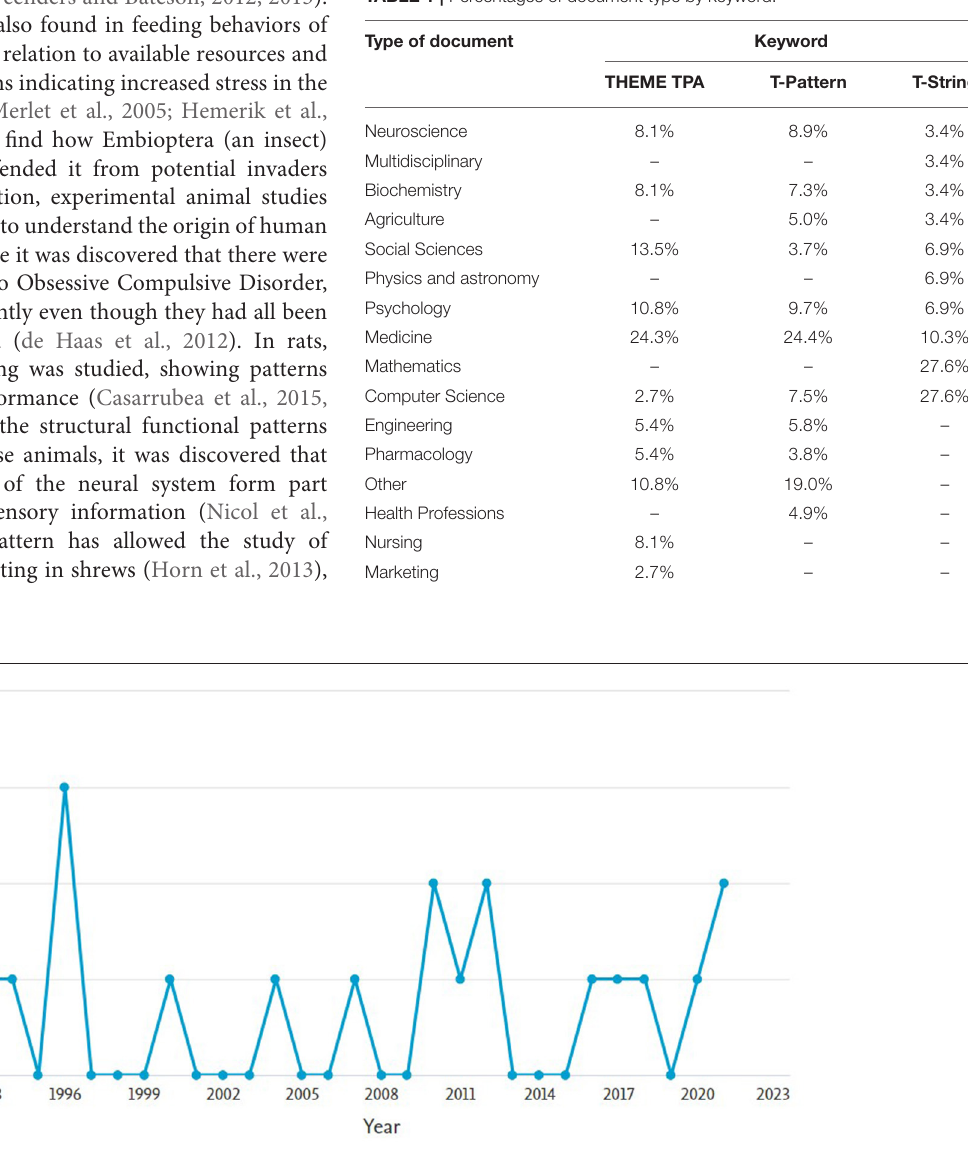
FIGURE 3 | Records found in Scopus for the keyword “T-String.”